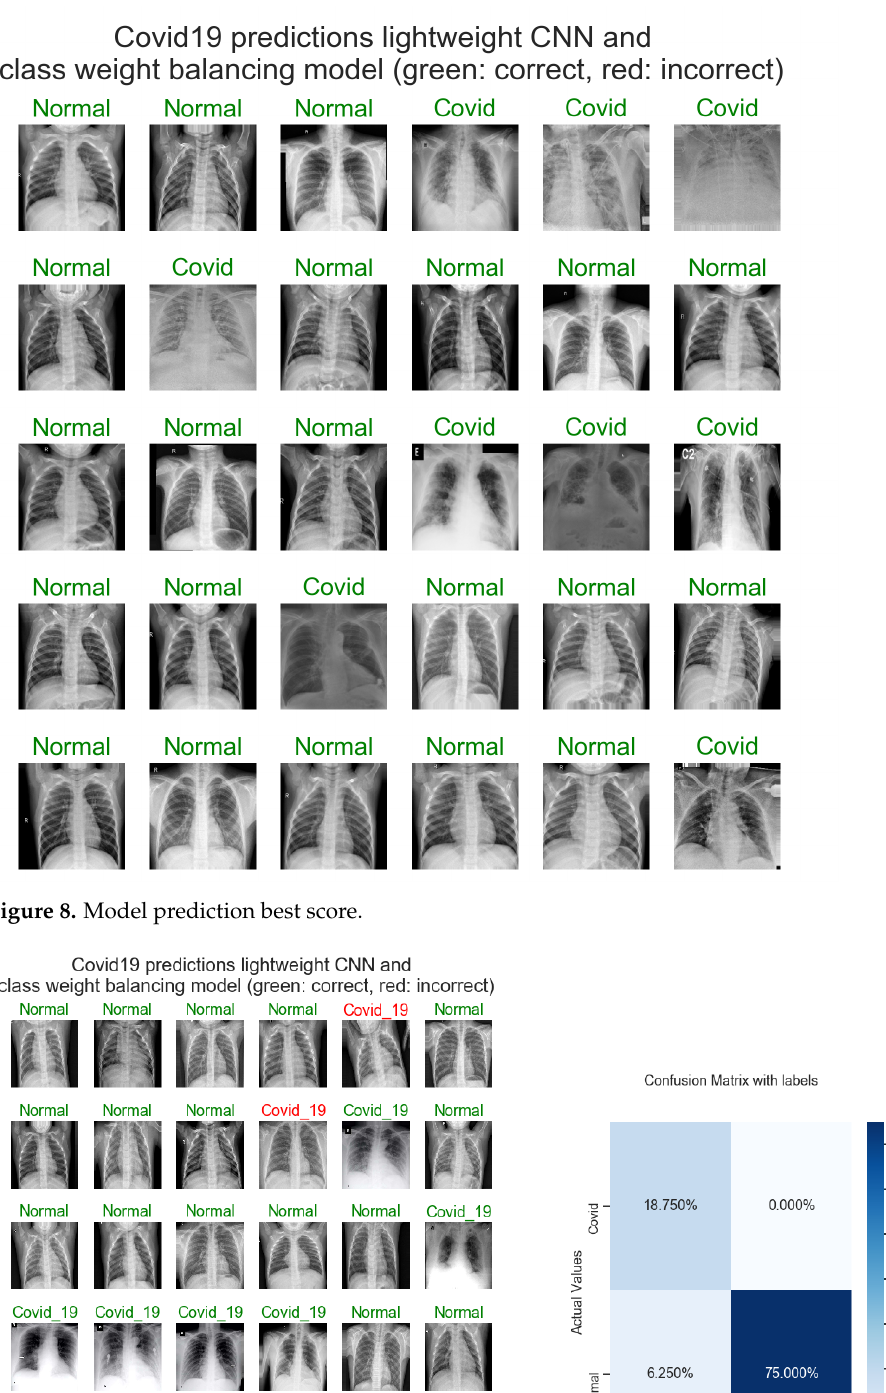
Figure 9. The worst case of the proposed model with Confusion